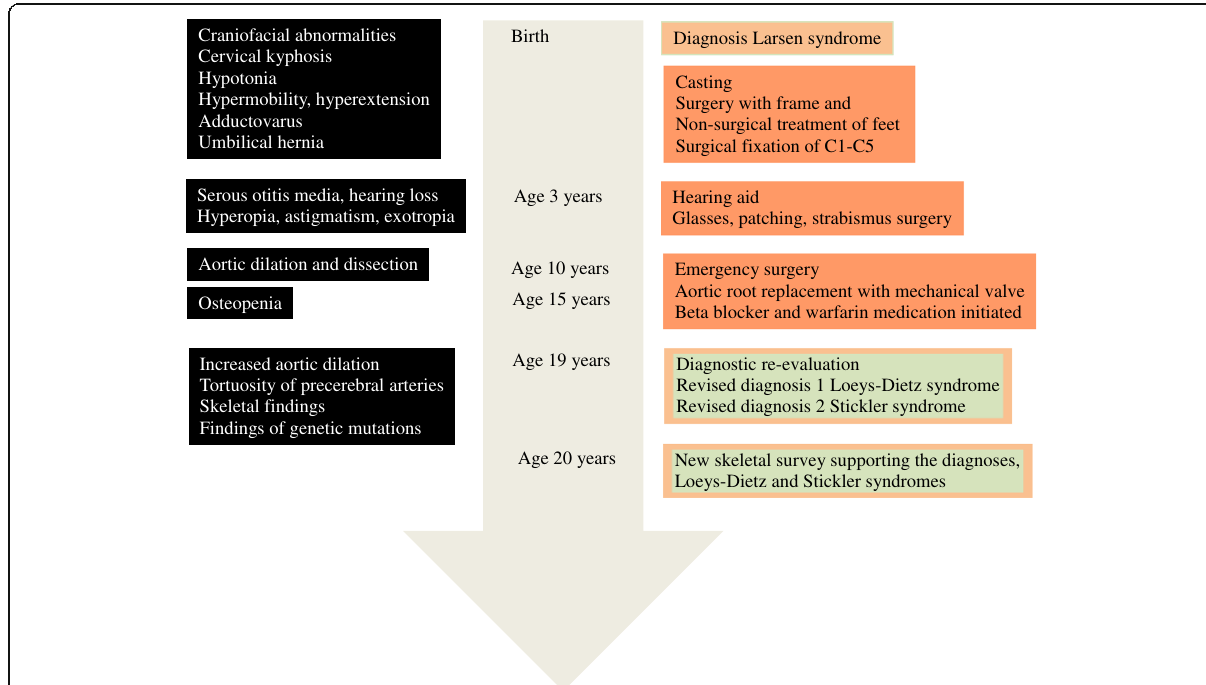
Fig. 5 Timeline for the case report on clinical diagnosis of Larsen syndrome, Stickler syndrome and Loeys-Dietz syndrome in a 19 year old male